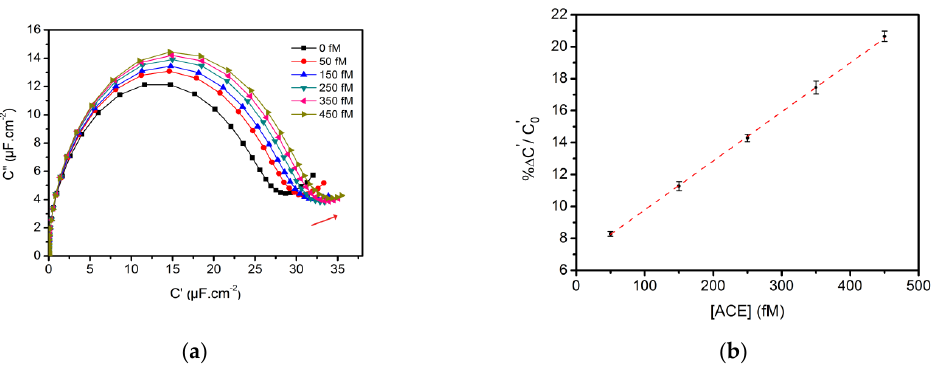
Figure 4. ( a ) Capacitance curves before and after incubation at various acetamiprid concentrations in Phosphate-buffered saline (PBS); ( b ) Calibration curve of the biosensor displaying the relative variation of redox capacitance %ΔC ′ /C 0′ vs. [ACE].